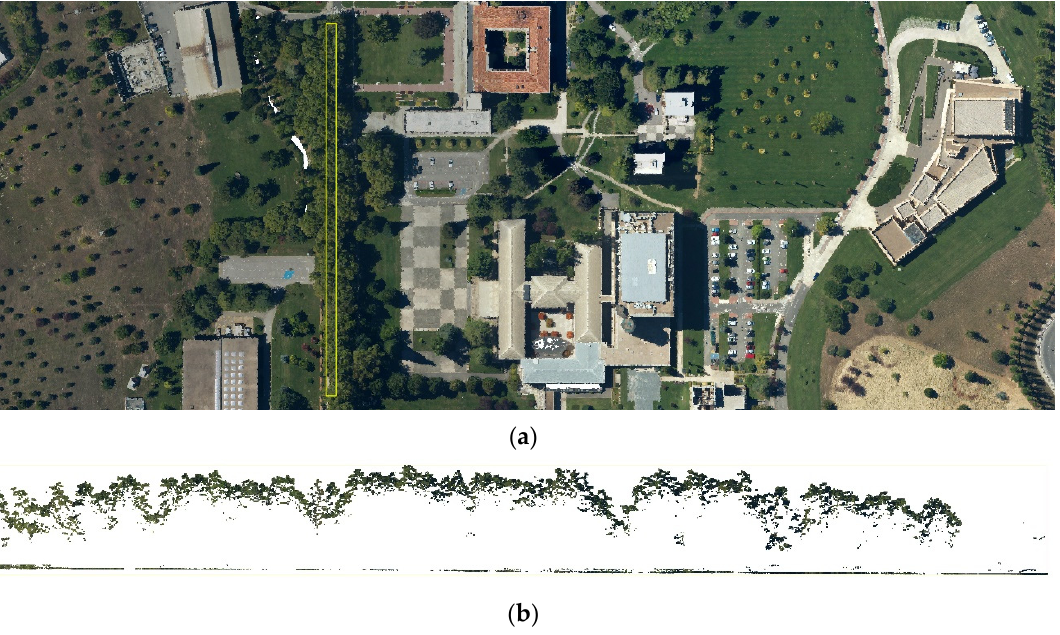
Figure 4. UNAV campus, vegetation strip example: ( a ) 2017 LiDAR Cloud Plan, density: 14